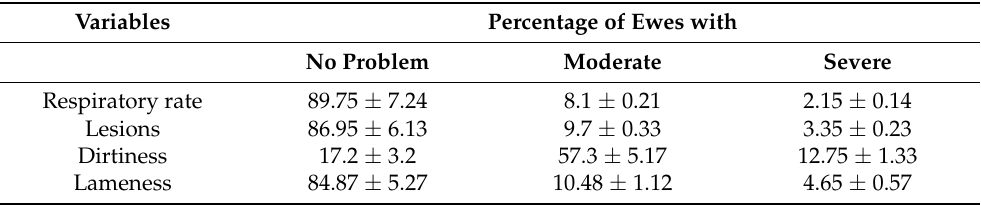
Table 2. Mean ± standard deviation (SD) of the selected health indicators measured in 52 farms for ewes at lambing and mid-lactation.